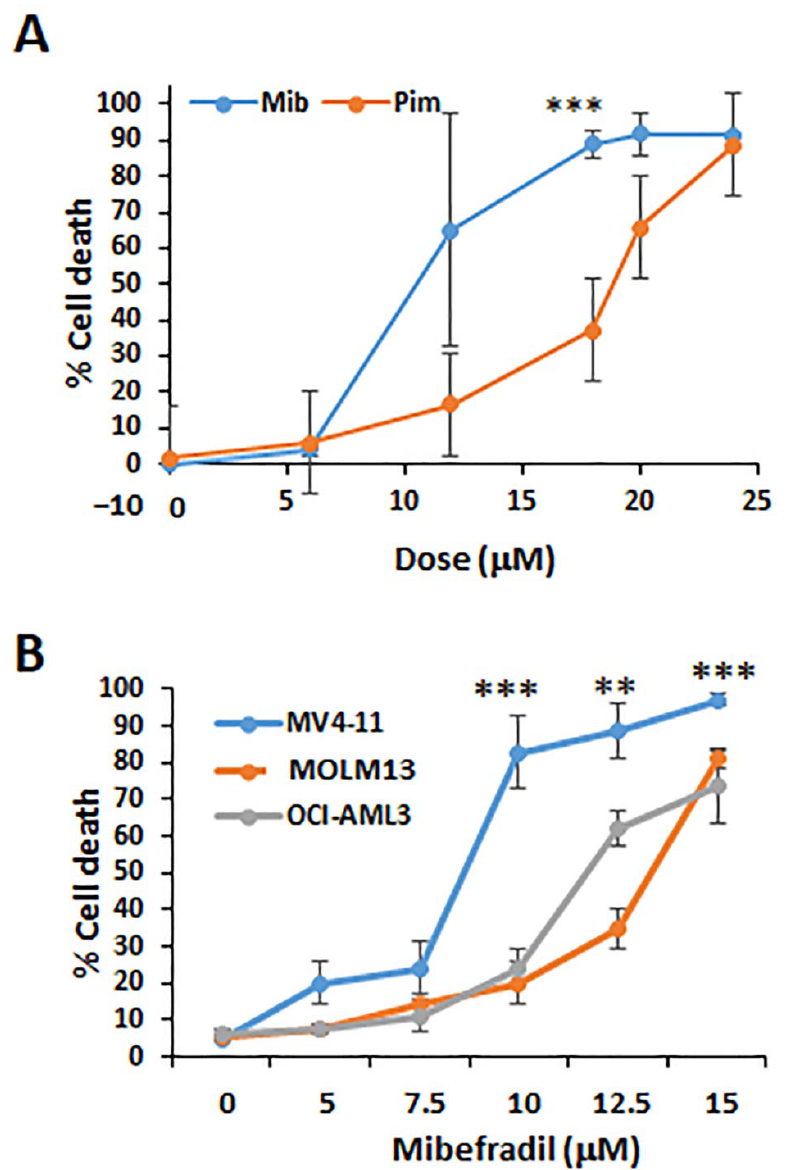
Figure 8. Pimozide and mibefradil have comparable activity on MV4-11 cells. ( A ) Pimozide and mibefradil were compared to determine whether their cytotoxicity profiles are similar in MV4-11 cells treated for 48 h with either drug. p values are relative to OCI-AML3 cells for n = 3. ( B ) Mibefradil was also tested in MV4-11 cells for 48 h and compared with MOLM13 and OCI-AML3 cells that express either low levels of Flt3-ITD or no Flt3-ITD, respectively. p values are relative to OCI-AML3 cells. ** p < 0.01; *** p <